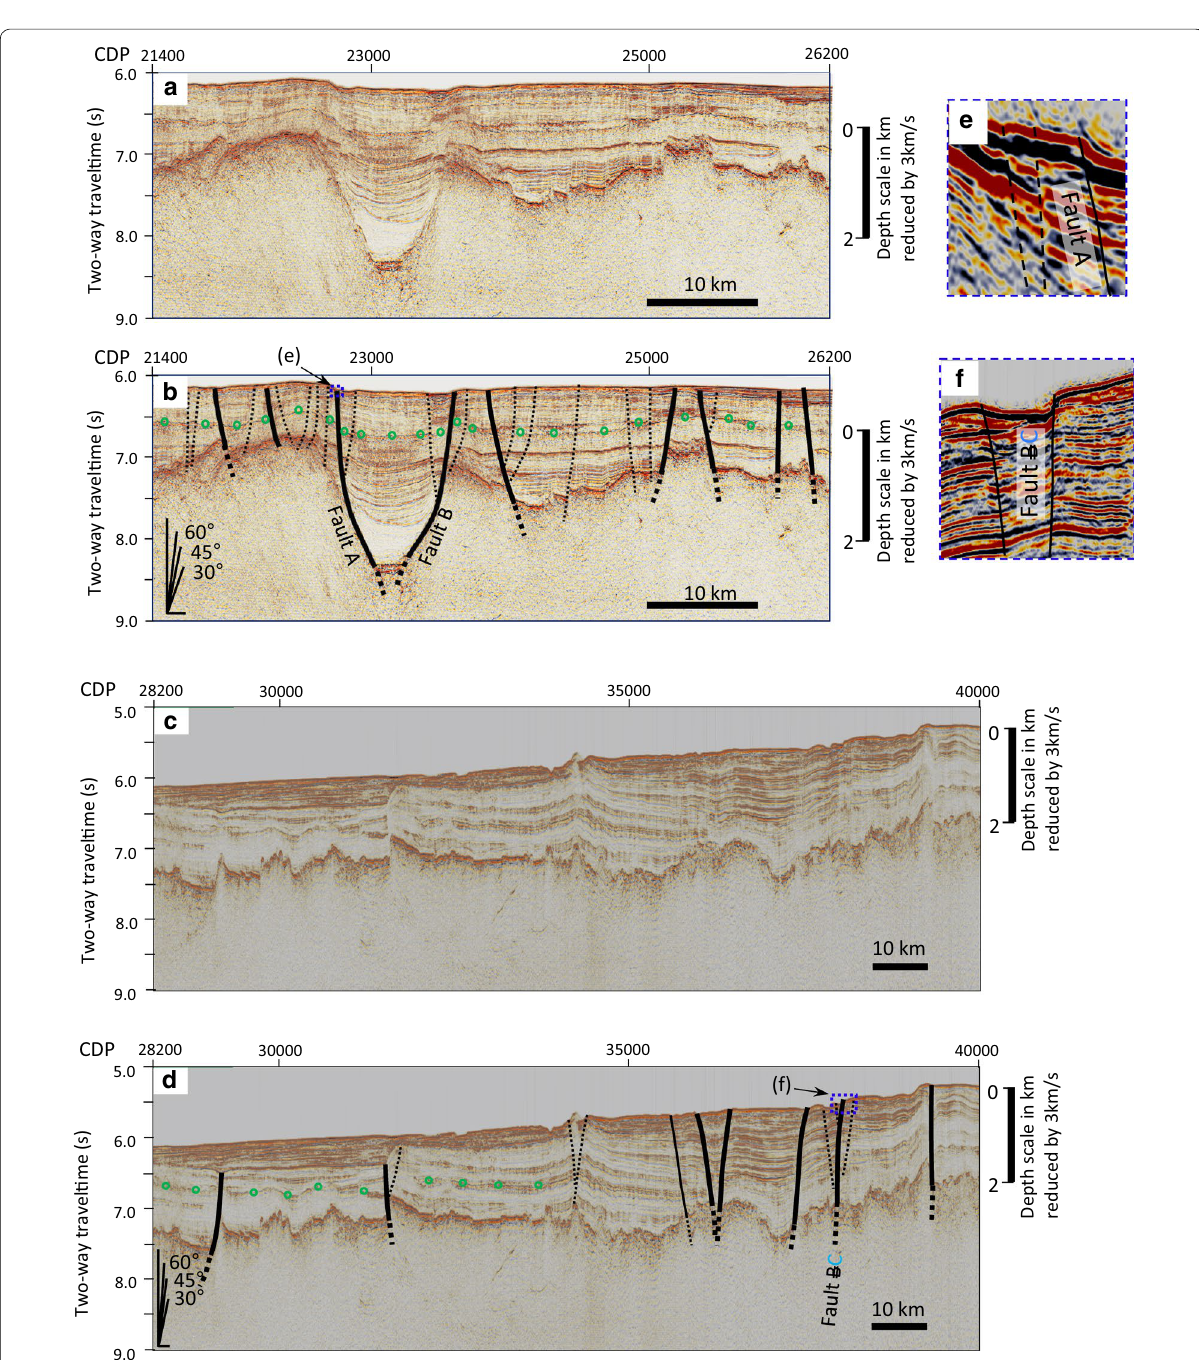
Fig. 8 Enlarged seismic reflection sections. A basement depression and surrounding many faults are visible in the panels ( a ) and ( b ). Both folding structures and faults are observable in the panels ( c ) and ( d ). Fault displacements at and immediately below the seafloor are enlarged in the top‑ right panels ( e ) and ( f ), suggesting that those faults are presently active. Green open circles in ( b ) and ( d ) show the upper boundary of the lower Shikoku Basin succession, which is middle Miocene to lower Pliocene in age (Ike et al.